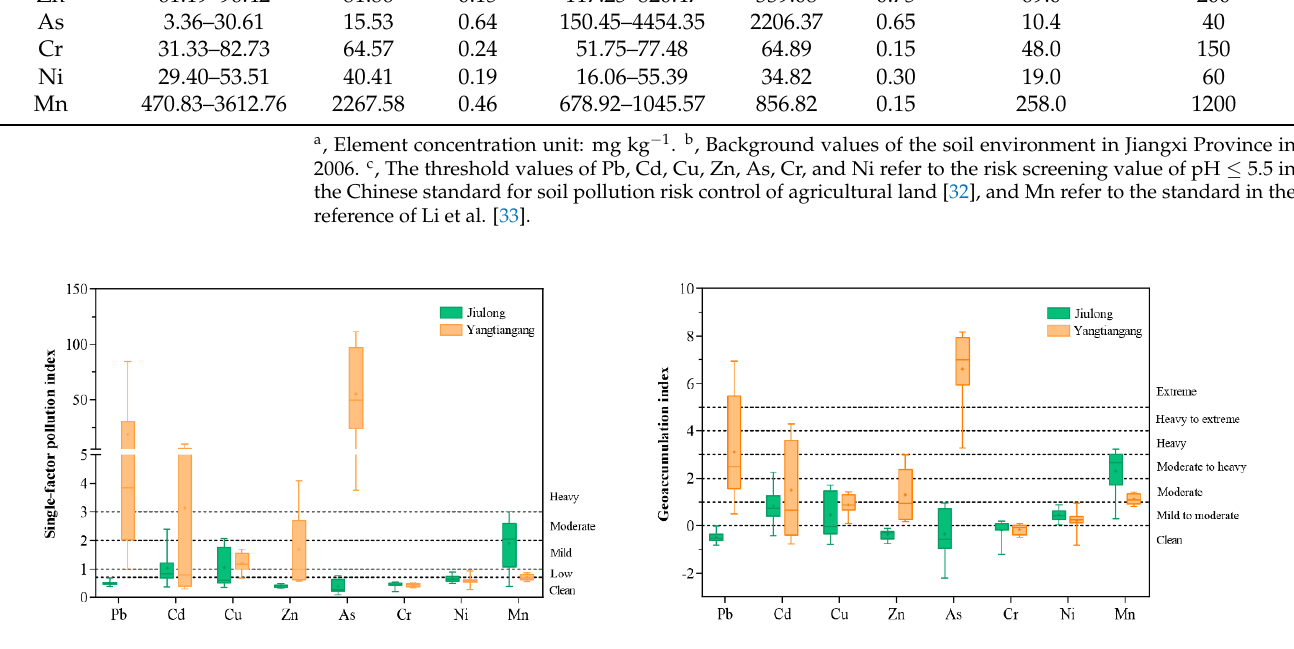
Figure 2. The single–factor pollution index and the geoaccumulation index of eight HM elements in two tailing areas. two tailing